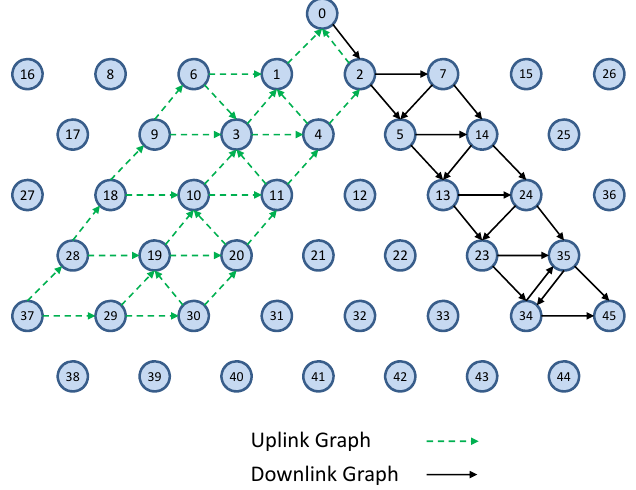
Figure 8. A sample connection establishment between Nodes 37 and